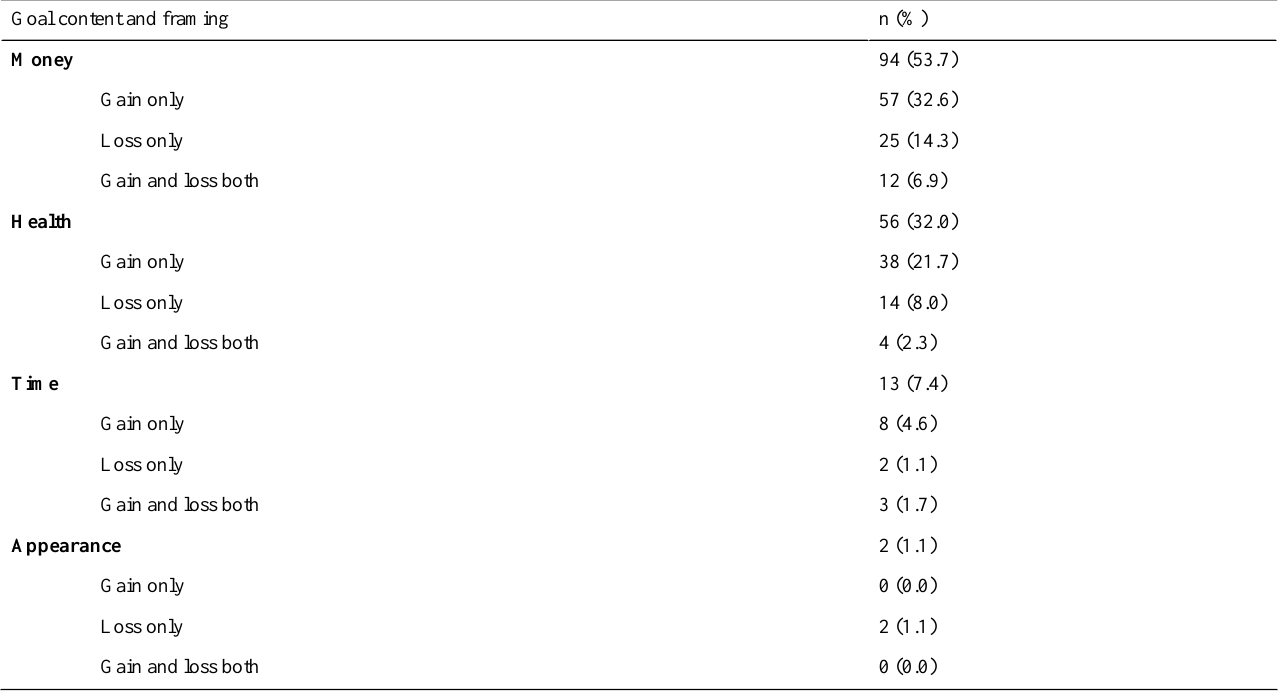
Table 3. Implied goal content and framing type in smoking cessation apps available in South Korea (N=175).